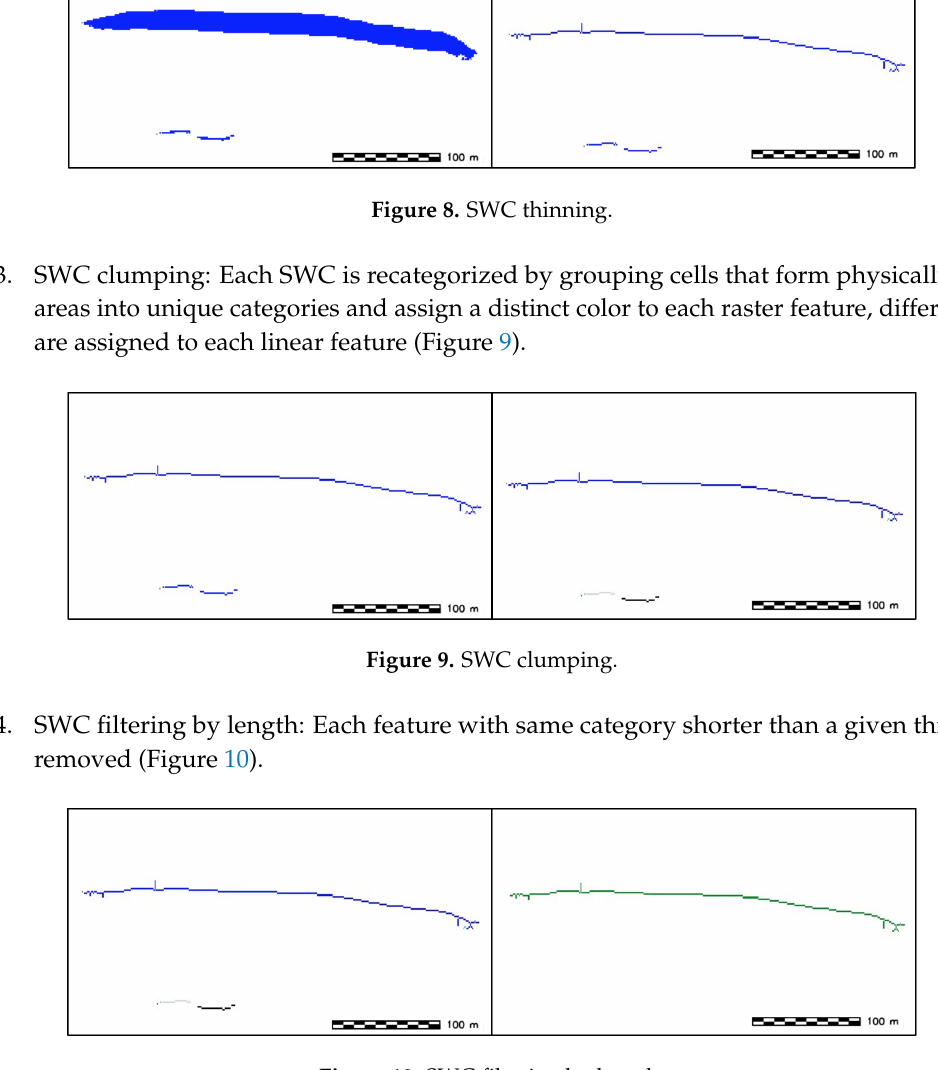
Figure 10. SWC filtering by